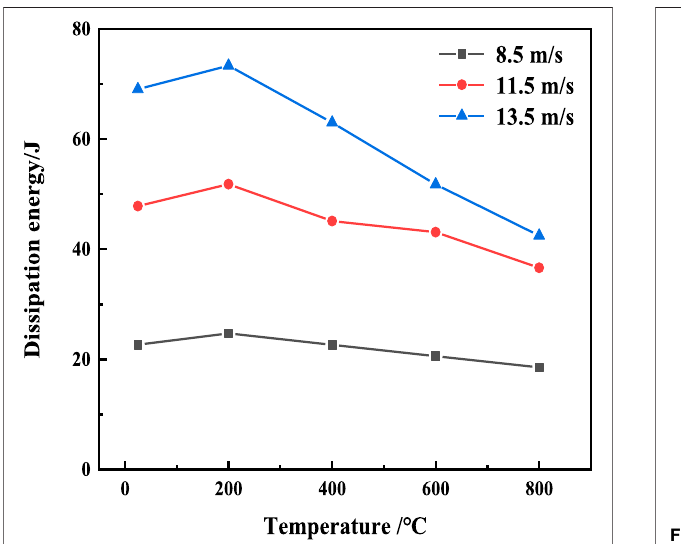
FIGURE 6 | Variations in dissipated energy under different working conditions.